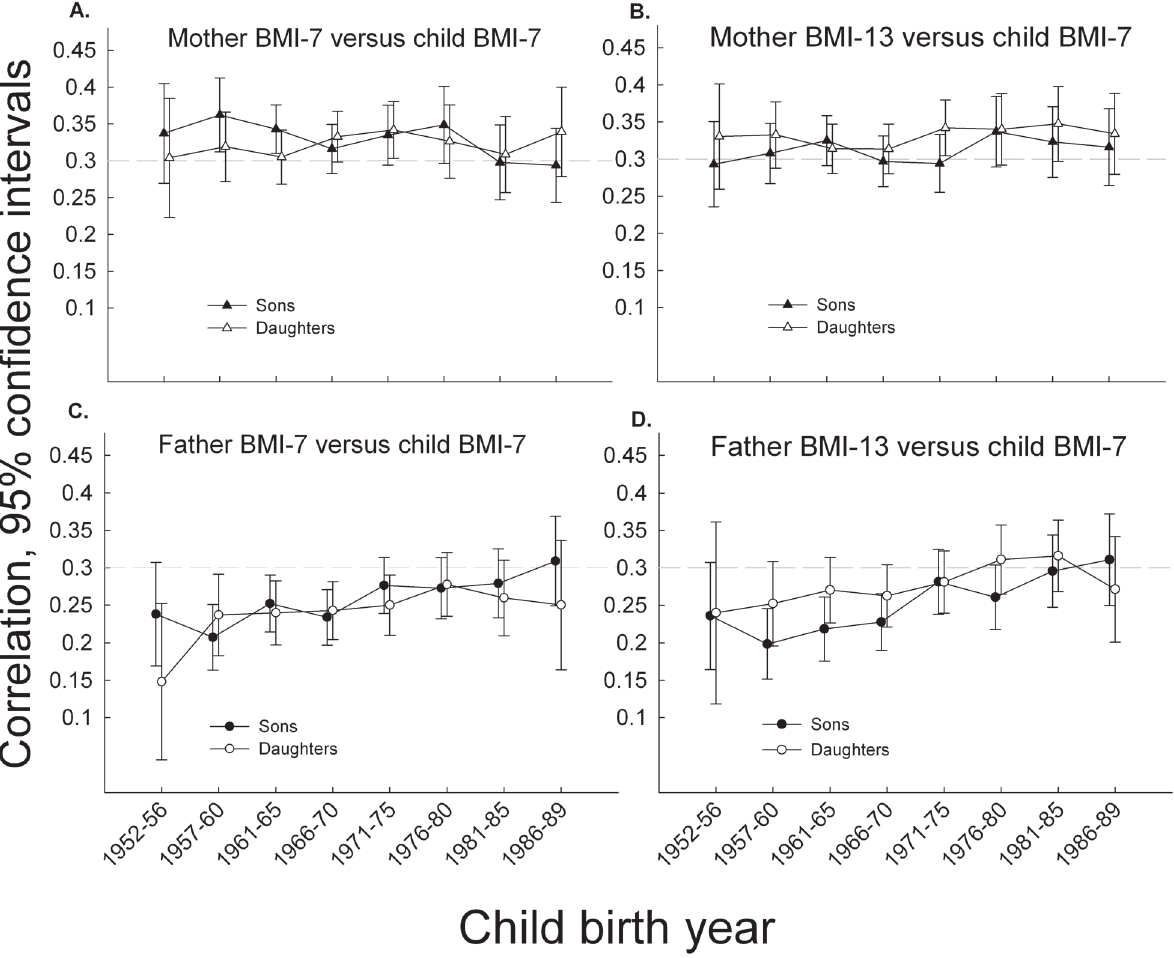
Figure 2. The figure shows four panels of BMI correlations across eight intervals of child birth year. Mother-child correlations shown in panels A & B and father-child correlations shown in panels C & D using age 7 and 13 year BMI z-scores (BMI-7 and BMI-13, respectively), respectively, in parents, and age 7 year BMI z-scores (BMI-7) in children. Test for trends across birth year intervals: Mother BMI-7 versus son BMI-7, p=0.006; mother BMI-13 versus daughter BMI-7, p=0.84; father BMI-7 versus son BMI-7, p=0.007; father BMI-7 versus daughter BMI-7, p=0.37. Mother BMI-13 versus son BMI-7, p=0.96; mother BMI-13 versus daughter BMI-7, p=0.56; father BMI-13 versus sonBMI-7, p , 0.001; father BMI-13 versus daughter BMI-7, p=0.37. The grey dotted line is a grid line at the correlation of